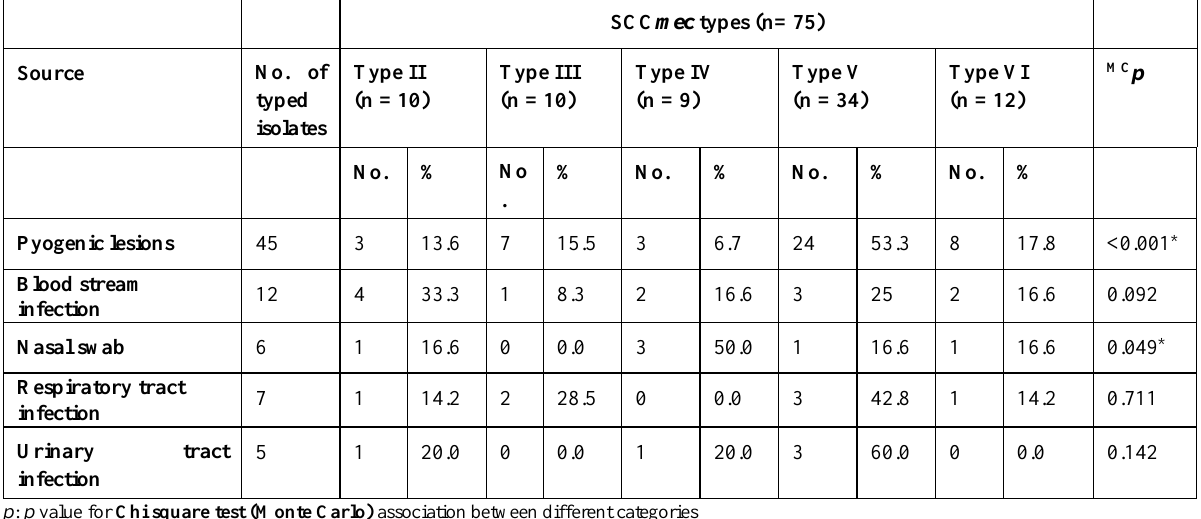
Table 4. Correlation between SCC mec types and their source clinical condition.